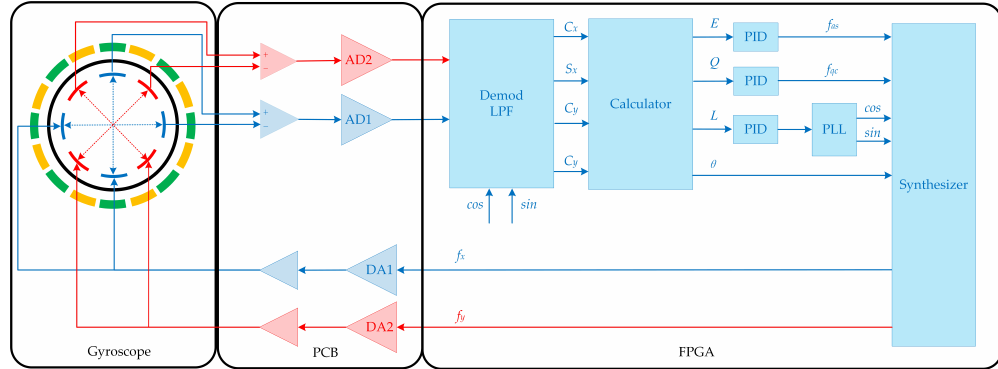
Figure 4. Block diagram of the electronics and control loops. The control system is implemented based on FPGA algorithm.